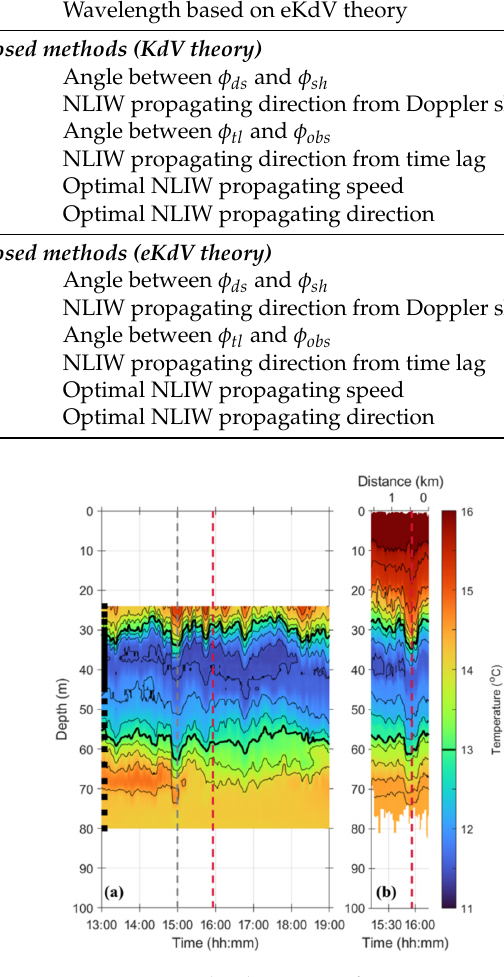
Figure 4. Time-depth pattern of water temperature observed from ( a ) northern mooring (VLA1) and ( b ) UCTD during the SAVEX15. The contour interval is 0.5 °C. The 13 °C isotherm is denoted by a thick black line. The times of NLIW observations at the VLA1 and UCTD are denoted by vertical grey and red dashed lines, respectively. Depths of thermistors attached to the VLA1 are denoted by black squares on the left axes.